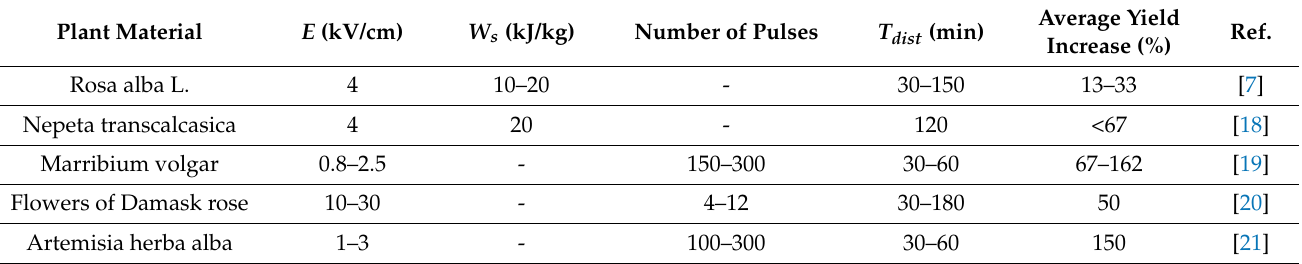
Table 6. Conditions and results of EO extraction yields, after PEF application, in the literature. Plant